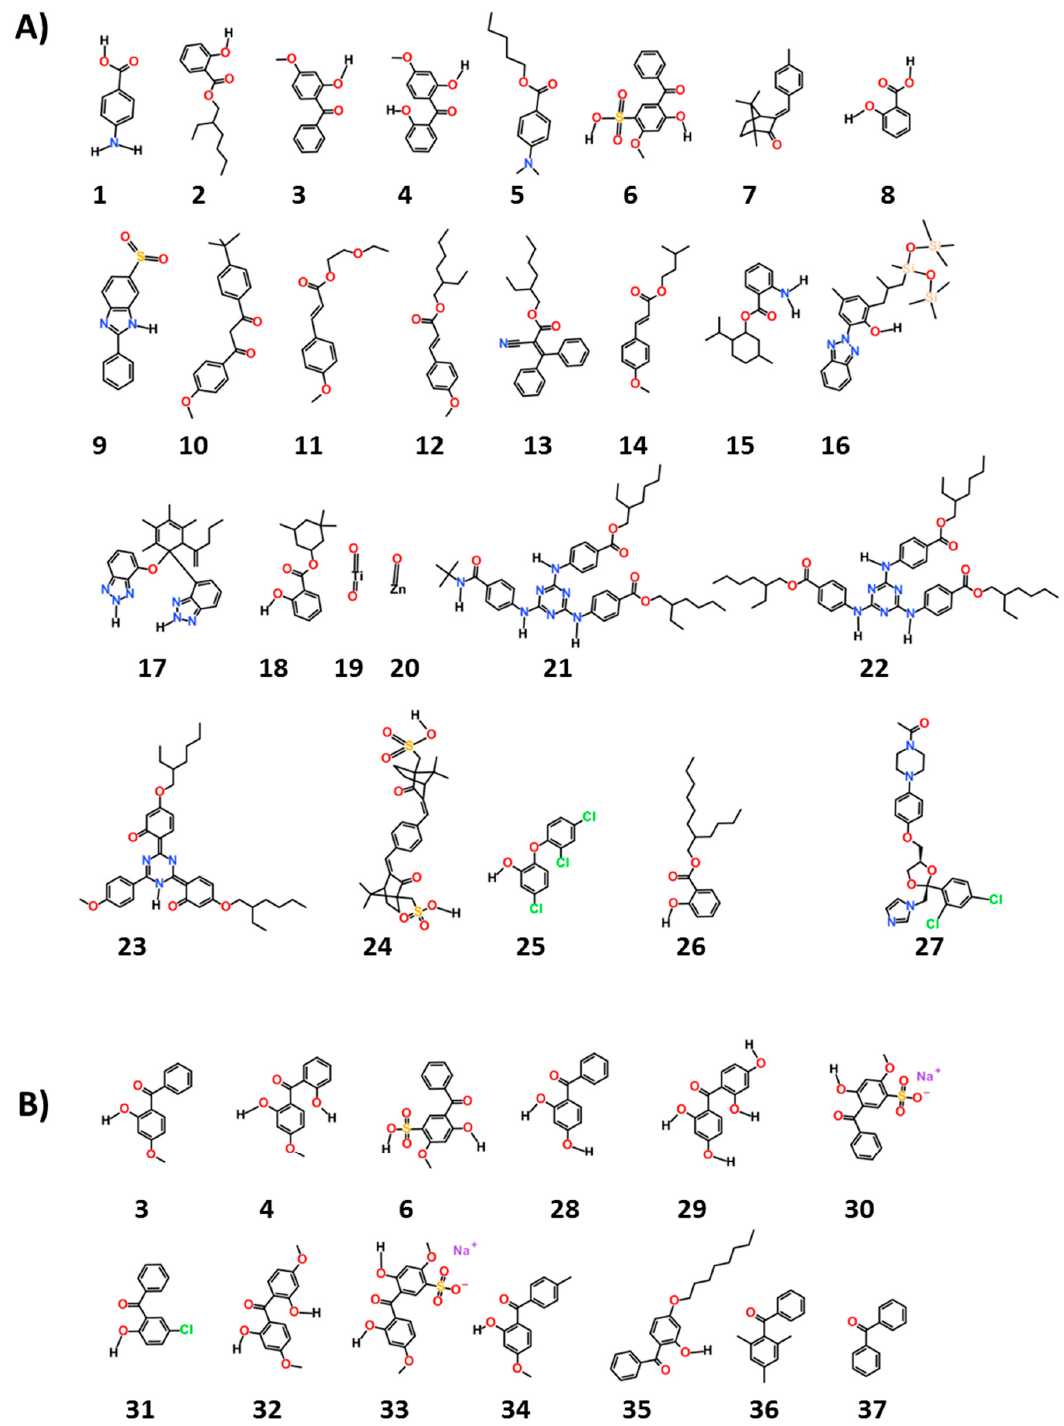
Figure 1. Structures of the 38 ingredients selected for this work. The numbers under structures were used in the text and Tables. The compounds shown in panel ( A ) were used in UV and non-UV filers; The compounds given in panel ( B ) are the benzophenone derivatives (potential excipients in sunscreen products and cosmetics).